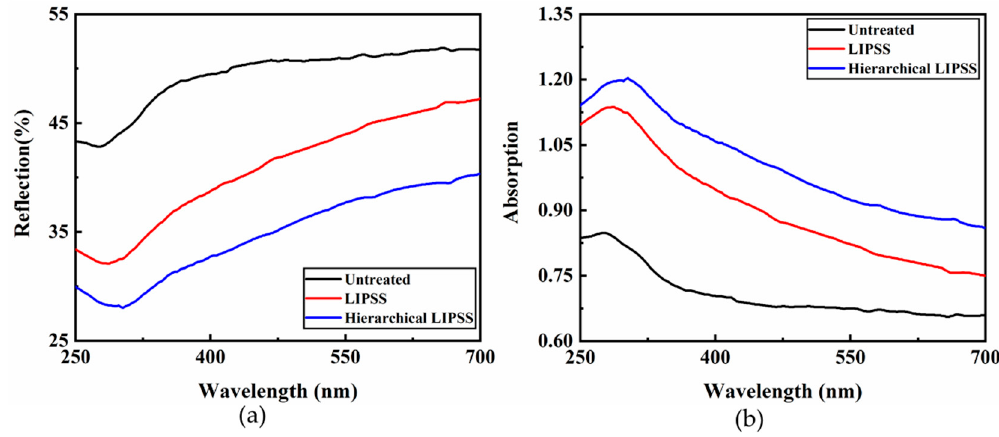
Figure 3. The reflection ( a ) and absorption ( b ) spectra of untreated, LIPSS, and hierarchical LIPSS substrate.